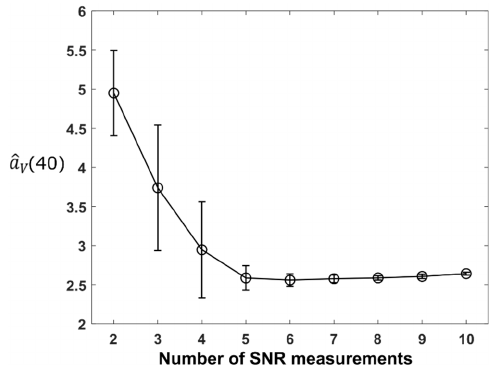
Figure 4. Using different numbers of SNR measurements to retrieve the specific attenuation for vertically polarized link at 40 degrees. The circles mark the average retrieved specific attenuations for area V across 100 independent simulations and the error bars show the standard deviation.